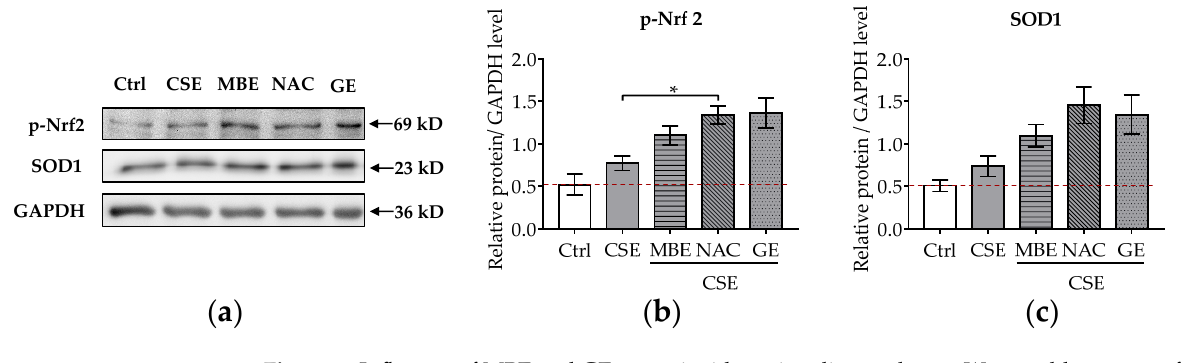
Figure 5. Influence of MBE and GE on antioxidant signaling pathway. Western blot was performed to detect the protein expression levels of p-Nrf2 and SOD1 in the co-culture system by day 7. ( a ) Representative Western blot image showing the protein levels of p-Nrf2 and SOD1 among different groups. The levels of p-Nrf2 ( b ) and SOD1 proteins ( c ) were measured in the co-culture system on day 7. Statistical differences were determined using the Kruskal–Wallis test followed by Dunn’s multiple comparison test. Data are presented as means ± SEM, and the significance is shown as * p < 0.05 vs. CSE group. N = 3, n = 2.